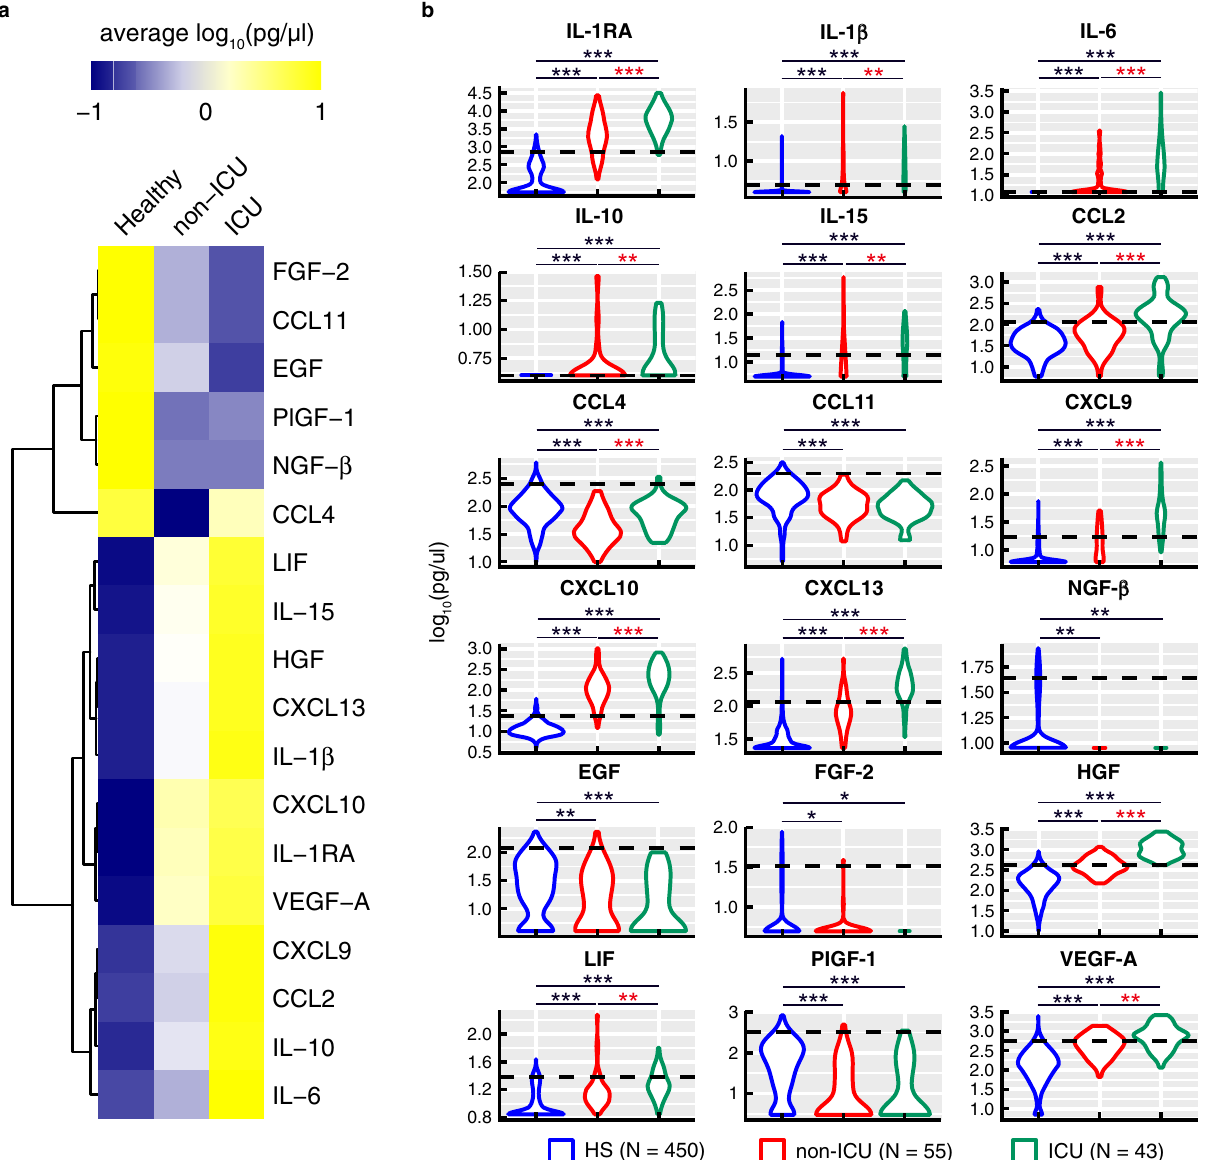
Fig. 2 Serum cytokine, soluble cytokine receptor, chemokine, and growth factor pro fi les in non-ICU and ICU COVID-19 patients. a Heat-map representing the mean serum cytokine levels detected in healthy subjects ( N = 450), non-ICU ( N = 55) and ICU ( N = 43) patients. Blue-to-yellow color code represents low-to-high average cytokine levels. Cytokine level similarities are represented by a dendrogram constructed by hiearachical clustering. b Levels of cytokines (IL-1 β , IL-6, IL-10, and IL-15), cytokine receptor (IL-1RA), chemokines (CCL2, CCL4, CCL11, CXCL9, CXCL10, and CXCL13) and growth factors (NGF- β , EGF, HGH, LIF, PIGF-1, and VEGF-A) in healthy subjects ( N = 450), non-ICU ( N = 55) and ICU ( N = 43) patients. Blue plots correspond to healthy subjects (HS), red plots corresponds to non-ICU patients and green plots correspond to ICU patients. Dotted line represents the upper normal values. Black stars indicate statistical signi fi cance between ICU or non-ICU patients and healthy subjects. Statistical signi fi cance ( P values) was obtained using two-sided Kruskal – Wallis test, using a Bonferroni correction. * P <0.05; ** P <0.01; *** P <0.001. Exact P values are available in Source Data fi